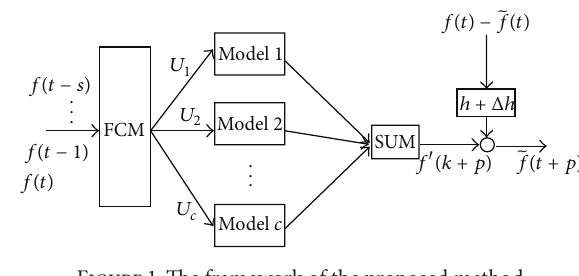
Figure 1: The framework of the proposed method.